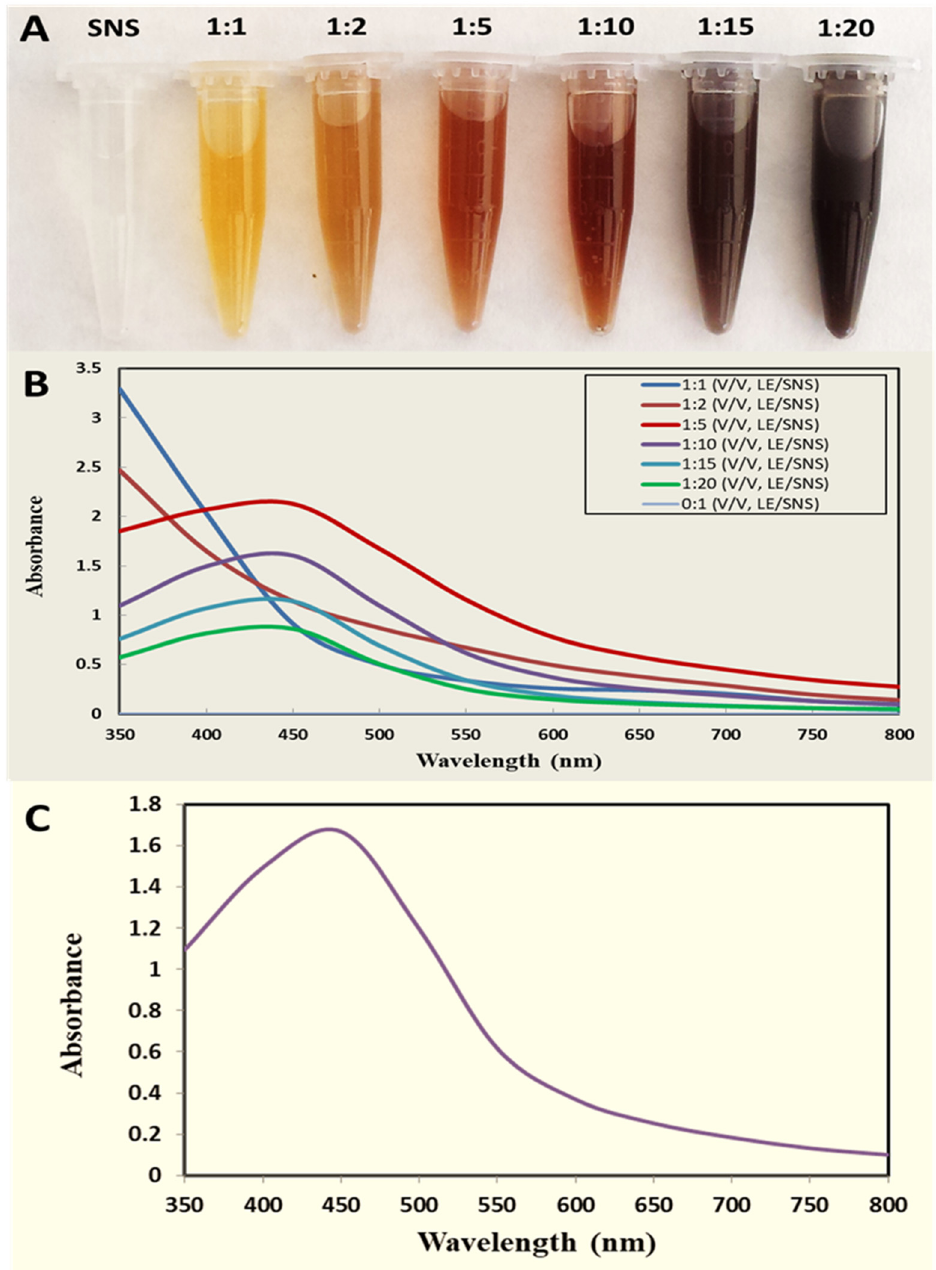
Figure 1. ( A ) Color change observed in reaction mixtures of AgNO 3 solution (SNS) + leaf extract (LE) at different ratios ( v / v ). ( B ) Optimization spectra of AgNPs at different ratios as observed by a UV-visible spectrophotometer. ( C ) Evaluation of the stability of synthesized AgNPs using a UV-visible spectrophotometer after 1 month of incubation of reaction mixture.